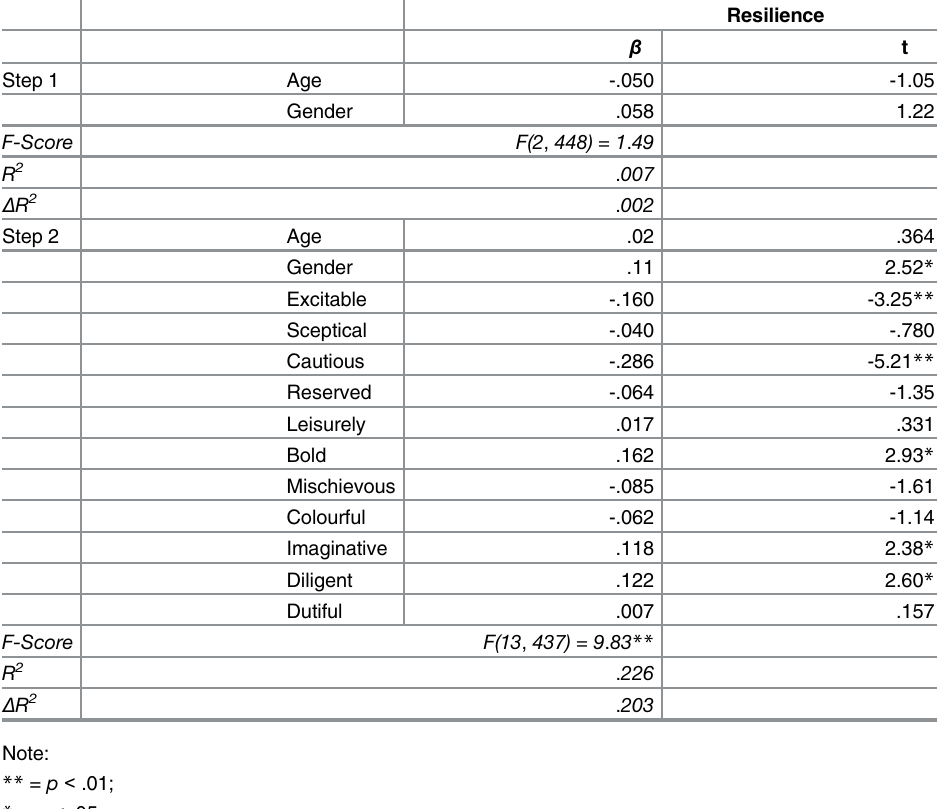
Table 9. Regression of Age, Gender, and HDS Dark Side as predictors of Resilience (RS-14).